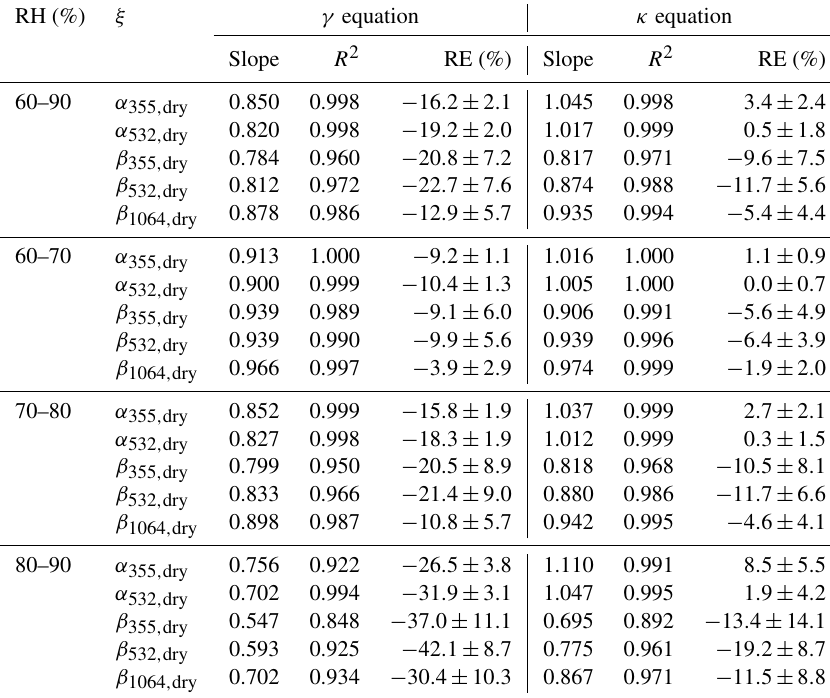
Table 2. Slopes of linear regressions, determination coefficients ( R 2 ), and relative errors (RE) between Mie-model-simulated particle dry backscatter or extinction coefficients and those inferred from humidogram functions. A total of 404575 pairs of the simulations from the in situ dataset are used. The REs are given in the form of mean value ± 1 standard deviation.